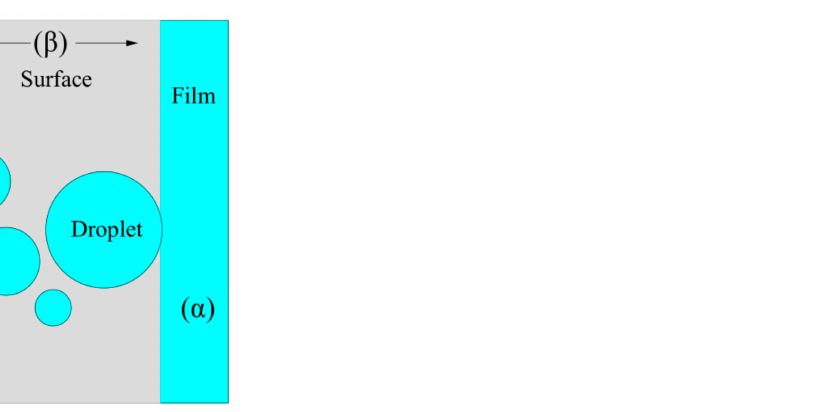
Figure 10. Concept of droplet migration mechanism between two different wettability regions [77]. Namib desert beetle model: Inspired by the Namib desert beetle, which captures water molecules by wax-free hydrophilic bumps and is transported by the waxy hydrophobic surround. Yin et al. [78] deposited the polytetrafluoroethylene nanoparticles prepared by femtosecond laser onto the superhydrophobic copper mesh, and the copper mesh was coated on the hydrophilic copper sheet to prepare the hybrid superhydrophobic- hydrophilic surface, as shown in Figure 11, and soaked in 1M NaOH, 1M HCl, and 10 wt% NaCl solution for 2 h, respectively, the surface has excellent corrosion resistance.